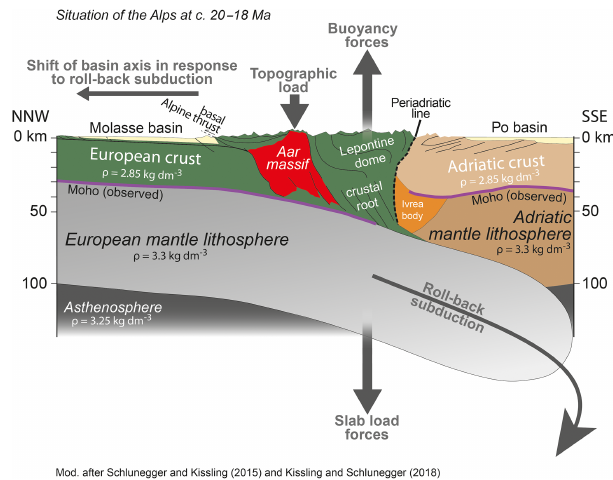
Figure 7. Simplified geological–geophysical model of the Alpine orogen for the time between 20 and 18Ma, showing the most im- portant geodynamic forces that might have shaped the Molasse basin and induced the transgression. Modified after Schlunegger and Kissling (2015) and Kissling and Schlunegger